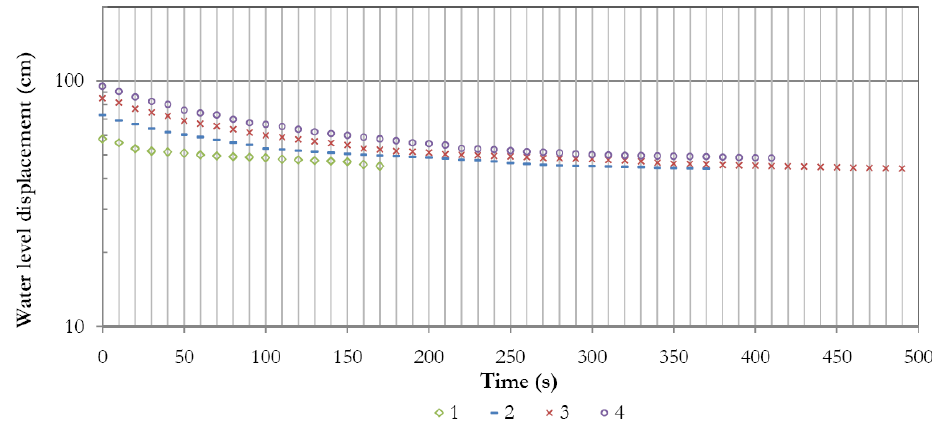
Fig. 5 Schematization of the CCL based on borehole descriptions. The average groundwater level for an average year is at about 40 cm below the ground level. a) Field resistivity plot with 3-layer interpretation (given by the shape of the obtained curve)